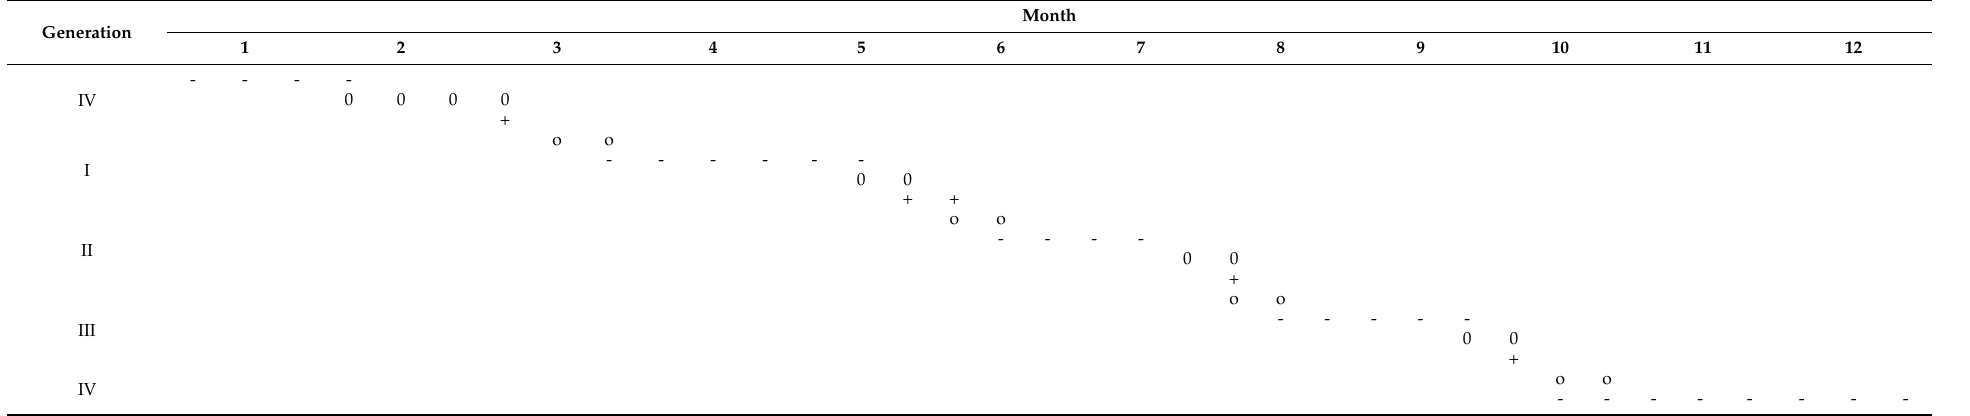
Table 3. Life cycles and emergence times of Dendrolimus punctatus in the North Central region of Vietnam.